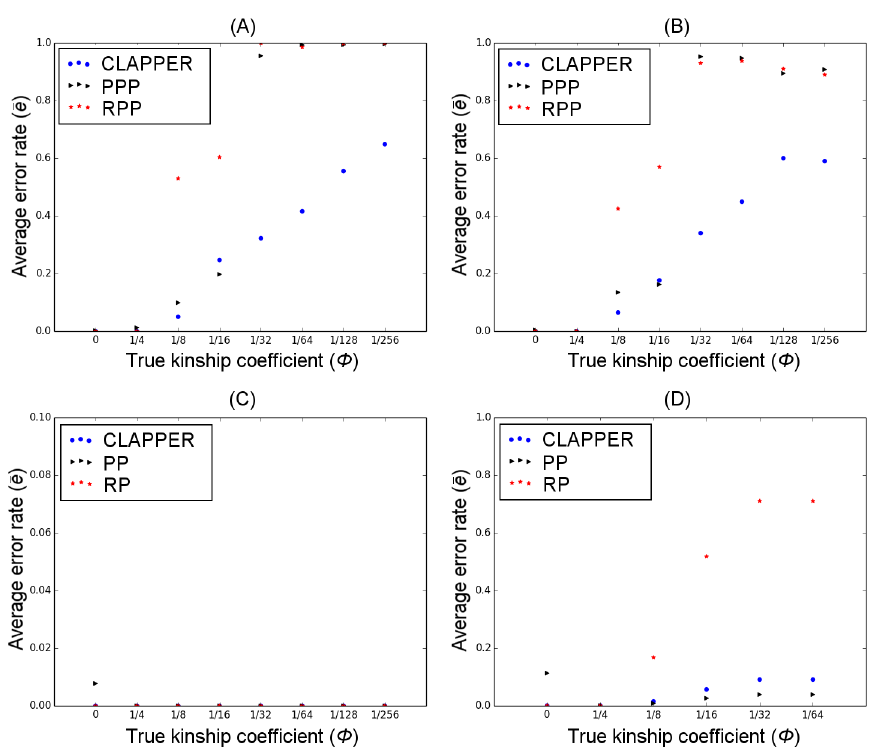
Fig 3. Comparison of prediction error rates. Each panel compares the averageerror rate between CLAPPER and competingmethods for a particular simulationscenario: (A) simulationA; (B) simulationB; (C) simulationC; (D) simulationD. The x-axis shows different relationshipcategoriesmeasuredby the kinship coefficient;the y-axis is the averageerror rate (cid:22) e (See Measuring the Error Rate). Analysis excludesall experiments that did not finish successfully or did not produceany outbred